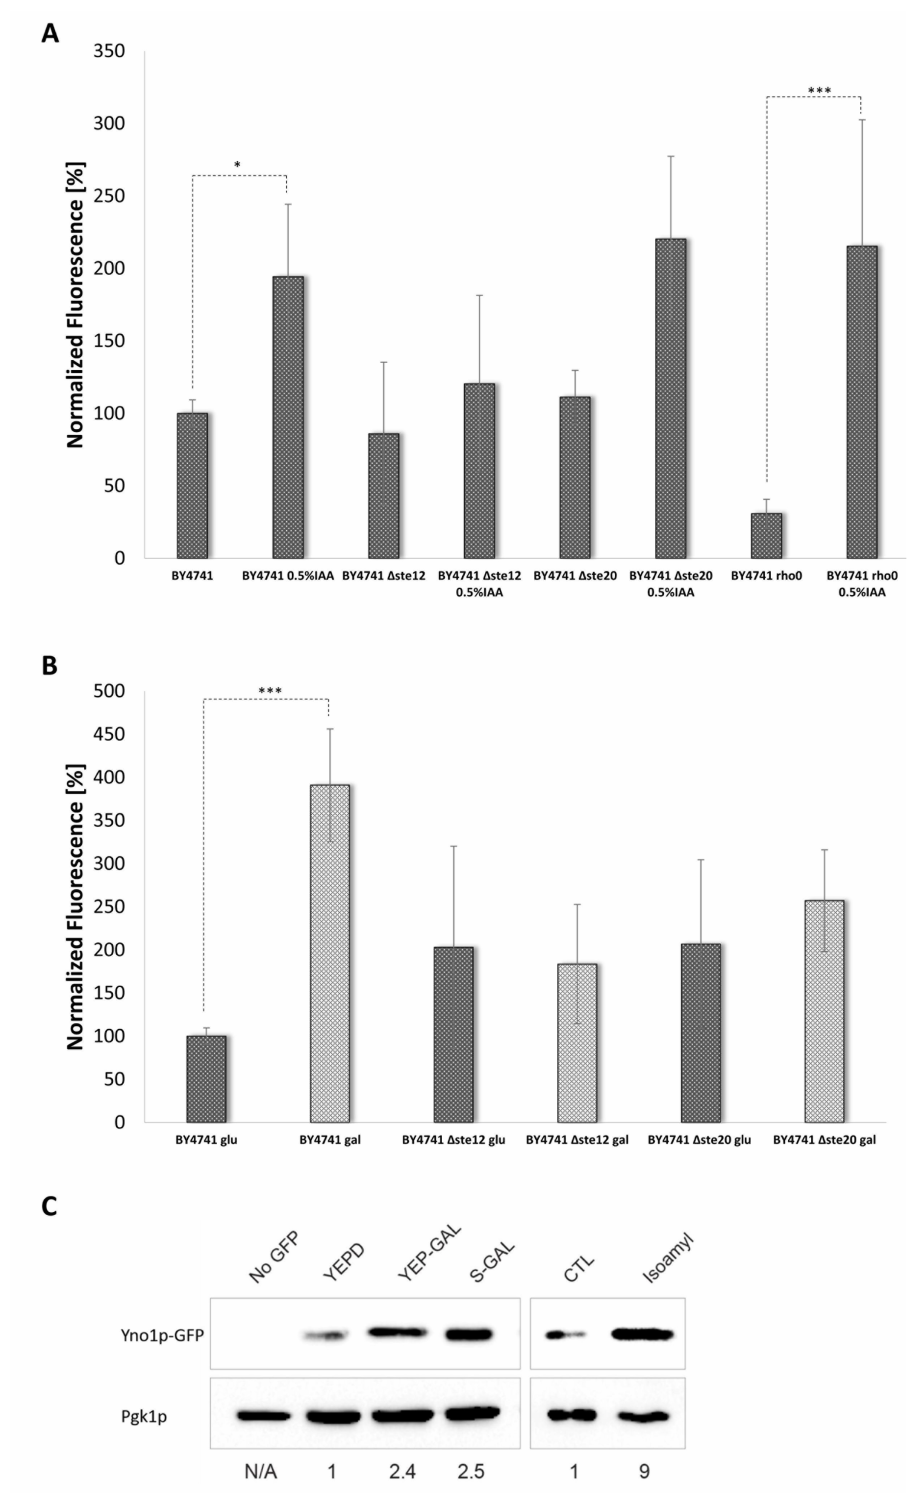
Figure 6. Expression of YNO1 under conditions that stimulate filamentous growth. The expression of YNO1 was analyzed using the GFP-reporter construct in the strains BY4741 rho+, BY4741 rho0, BY4741 ∆ ste20, and BY4741 ∆ ste12. Filamentous growth was induced by addition of 0.5% isoamyl alcohol (IAA) for 36 h ( A ) or growth in galactose media ( B ) (*: p < 0.1; ***: p < 0.01). In ( C ), immunoblot analysis of cells harboring a YNO1-GFP fusion (BY4741 YNO1 -GFP:: HIS3 ) were grown under the indicated conditions. A control strain (BY4741) was used for the no-GFP control. Equivalently run blots were probed using antibodies to Pgk1 as a loading control. Band intensity of GFP normalized to Pgk1 levels is shown below the blots and was determined by Bio-Rad XRS + Image Lab